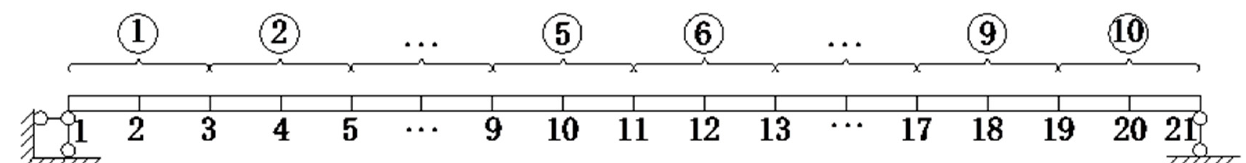
Figure 1. Model of simply supported steel beam.